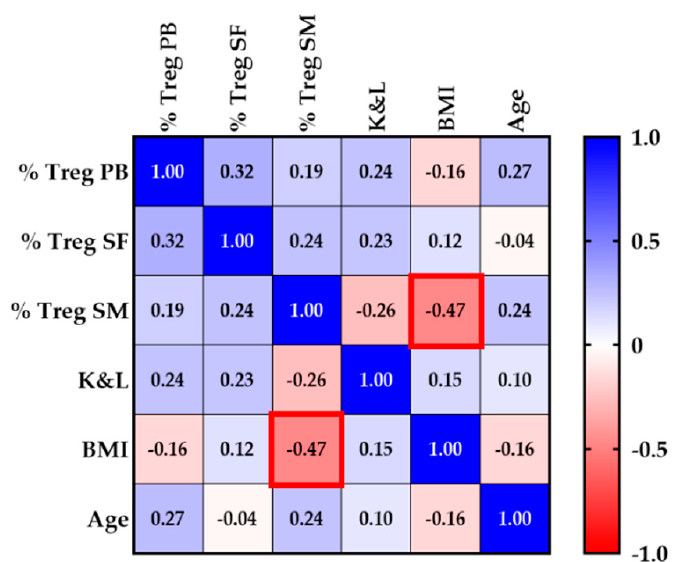
Figure 3. Heatmap of the correlation matrix screening for relevant associations between Treg pro- portions (% Treg) in peripheral blood (PB), synovial fluid (SF) and synovial membrane (SM) and OA-severity (K&L score), age and body mass index (BMI). A significant negative correlation was found between Treg proportions in SM and the BMI (bold red square; p = 0.003, r s = − 0.47). Values displayed in the squares of the correlation matrix represent the Spearman’s rank correlation coefficient (r s ) for every pair of data set. Bold red squares highlight significant correlations ( p -value < 0.05). K&L score = Kellgren and Lawrence score.